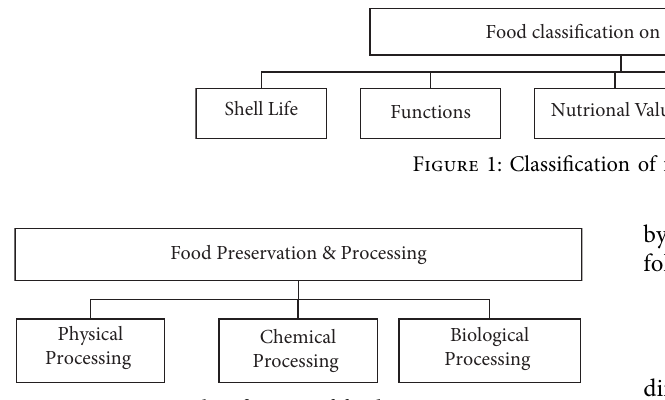
Figure 2: Classification of food